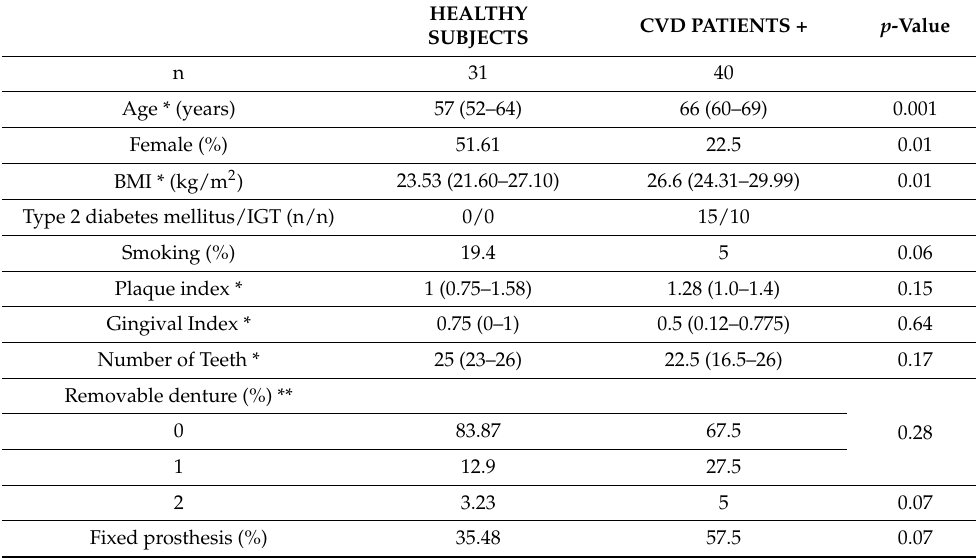
Table 1. General features of healthy subjects and CVD patients.